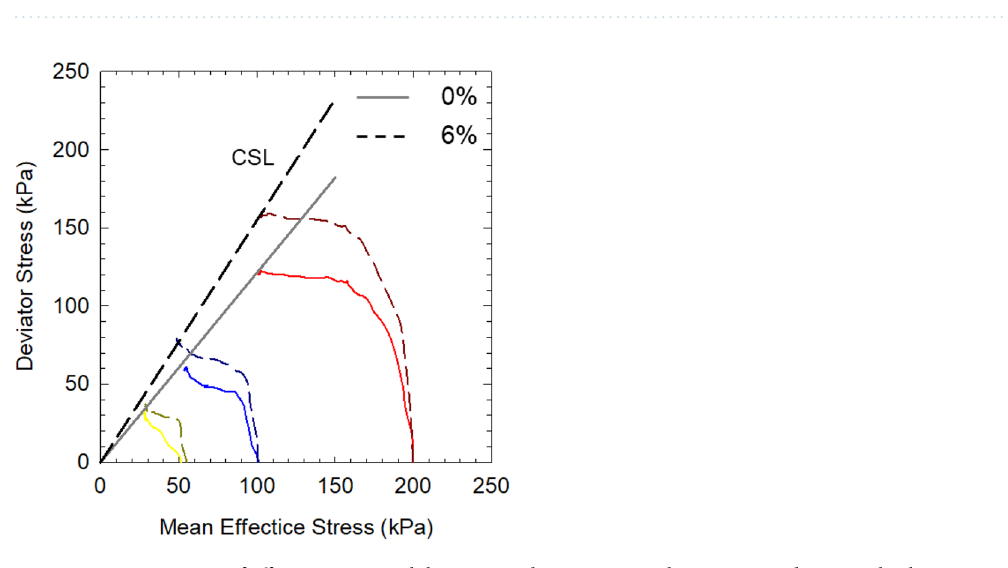
Figure 6. Comparison of effective stress path between soil specimens with DI water and 6% NaCl